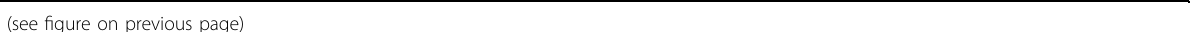
Fig. 2 PAK1 translocates to the cell periphery and colocalizes with STIM1. PAK1 (myc-tagged-WT, DA and DN forms) and/or STIM1 ( fl ag tagged- WT form) were expressed in HeLa cells overnight before the transfected cells were processed for confocal imaging with each primary monoclonal antibody and then with the appropriate secondary antibodies (Alexa Fluor 594- or Alexa Fluor 488-conjugated antibody, respectively), as described in the Materials and methods. The images were processed with a ZEN 2009 (Carl Zeiss). The area of colocalization ( a ) or lamellipodia ( b ) is marked with triangles. Scale bars: 5 µm. Endogenous PAK1 and STIM1 were detected with antibodies against PAK1 (Abcam, rabbit monoclonal) and STIM1 (Santa Cruz, mouse monoclonal) in HEK293 cells. The areas of nascent adhesions are highlighted with white dot boxes ( c ). Scale bars represent 10 and 5 µm,